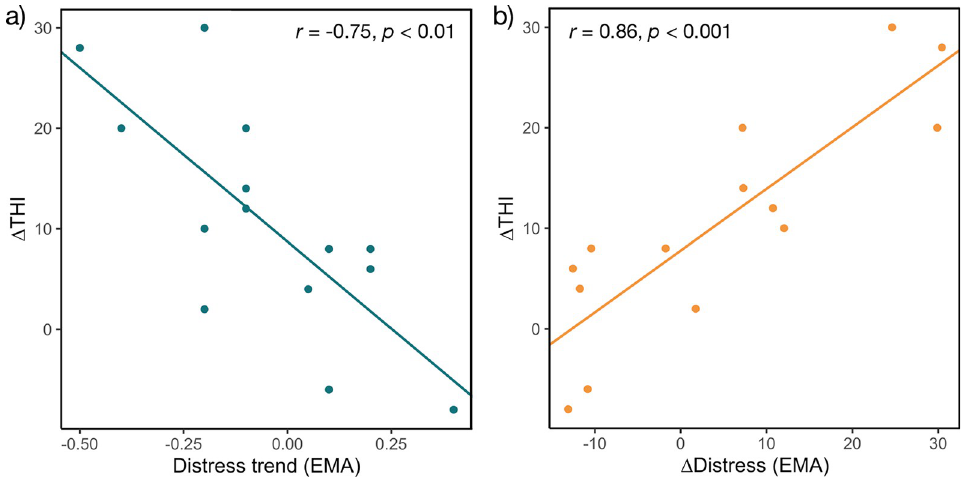
Fig 5. Correlation of Δ THI with improvement in EMA tinnitus distress. Pearson’s product-moment correlation of Δ THI with two EMA improvement scores: Distress trend (a) and Δ Distress (b). Δ THI = THI begin baseline–THI final visit; Distress trend = slope of tinnitus distress during intervention phase; Δ Distress = Baseline phase–end of intervention phase. N = 14.